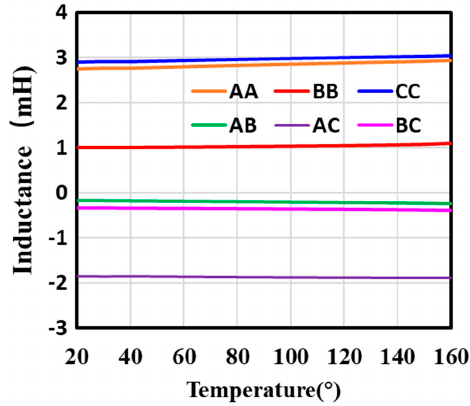
Figure 11. Inductance change of the windings.